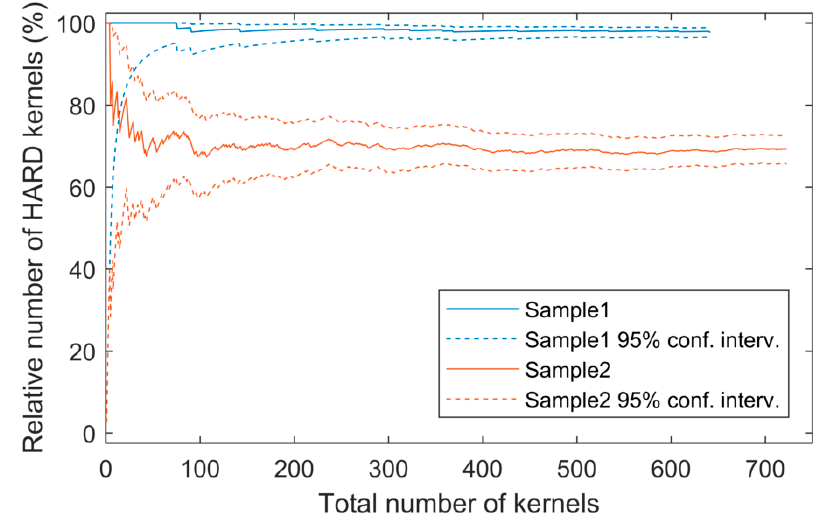
Figure 5 . Percentage of Hard kernels vs. the total numbers of kernels for two samples with two different qualities. The 95% confidence intervals are marked with dotted lines. Note that the confidence intervals decrease with the number of kernels.